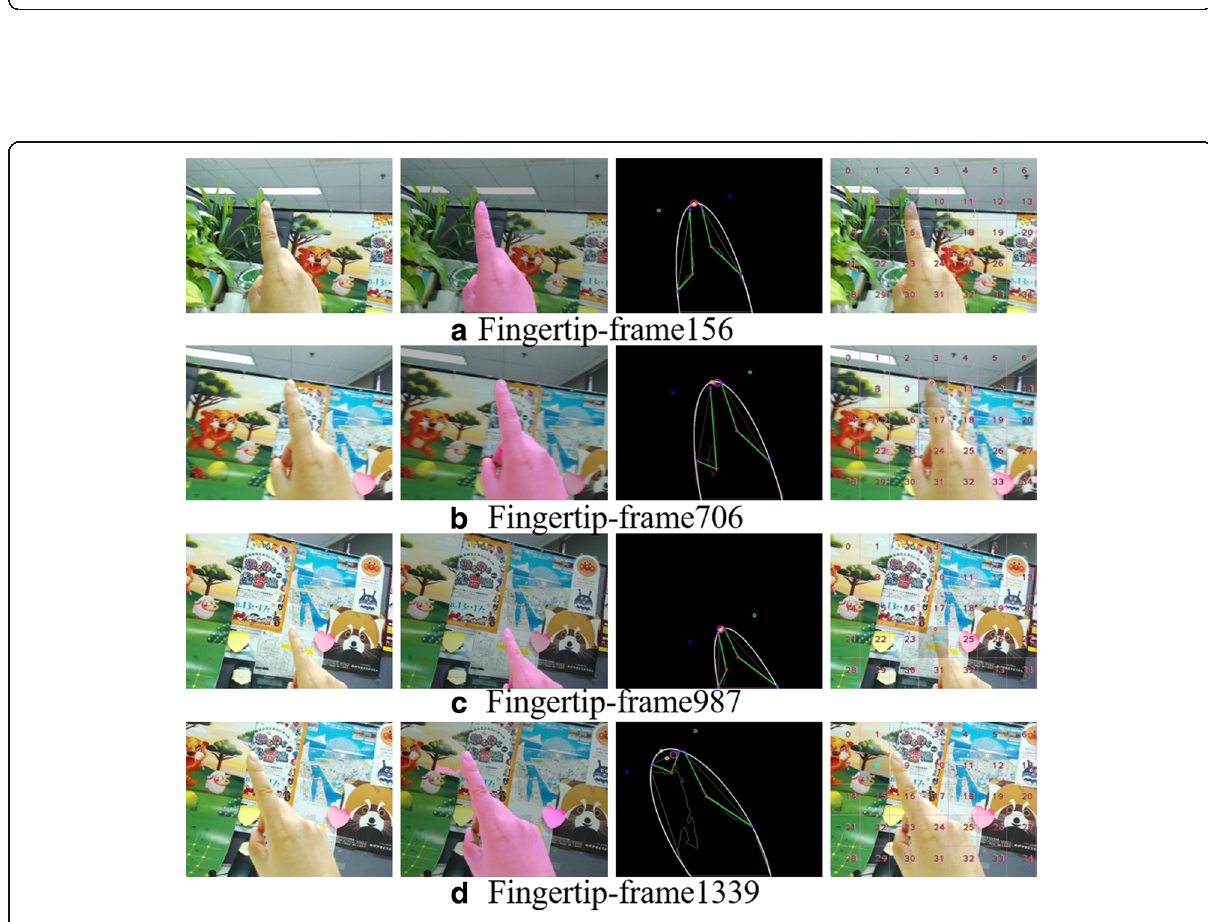
Fig. 8 Virtual keyboard interaction. a – d illustrate examples of fingertip detection for virtual keyboard interaction. Columns from left to right are original images, hand segmentation results overlapping on original images, fingertip detection by analyzing convex of hand segmentation result, and virtual keyboard